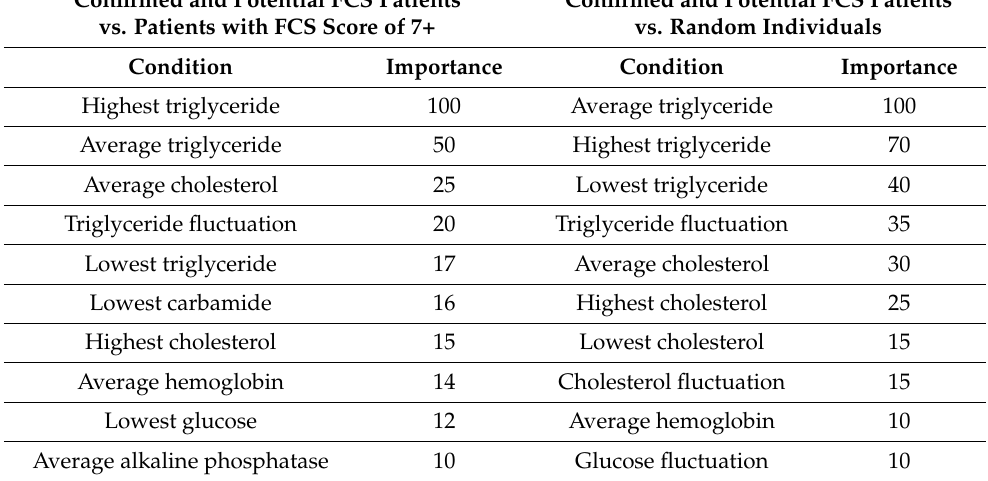
Table 6. Importance of conditions of the history in defining FCS, using all model trainings (expressed in relative importance scores, in the fractions of the most important features).